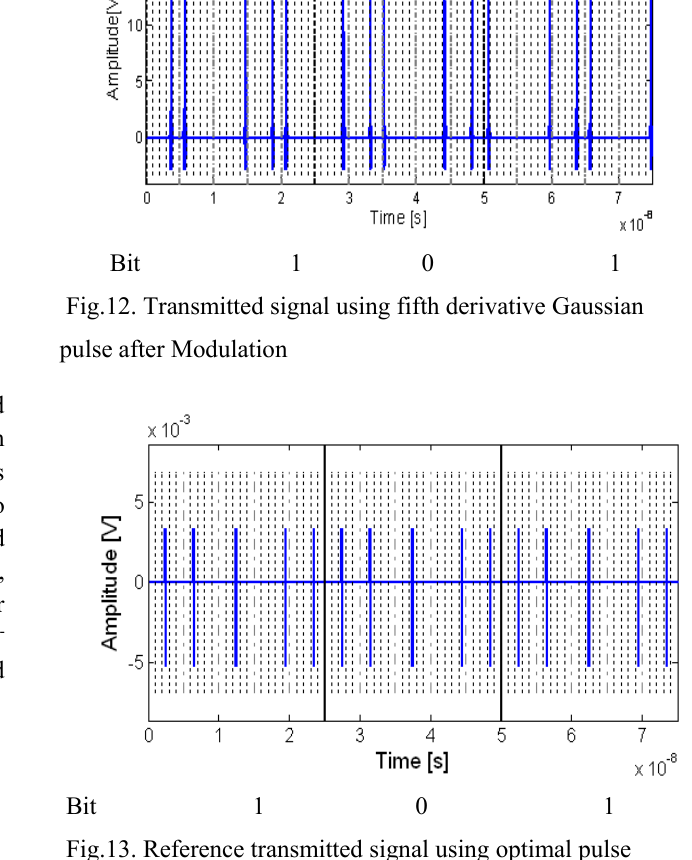
Fig.13. Reference transmitted signal using optimal pulse